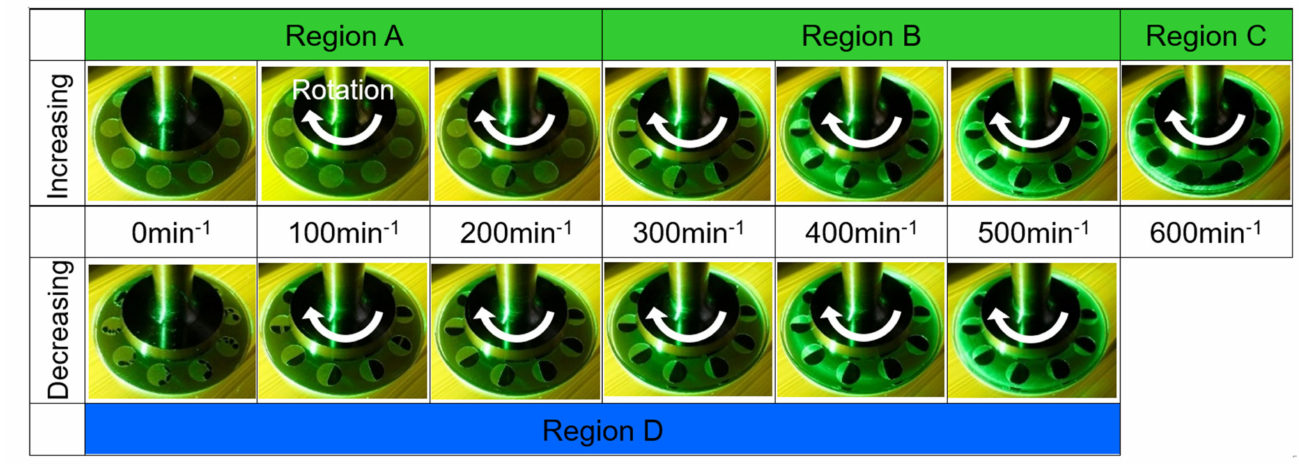
Figure 10. Observation results of the lubricating